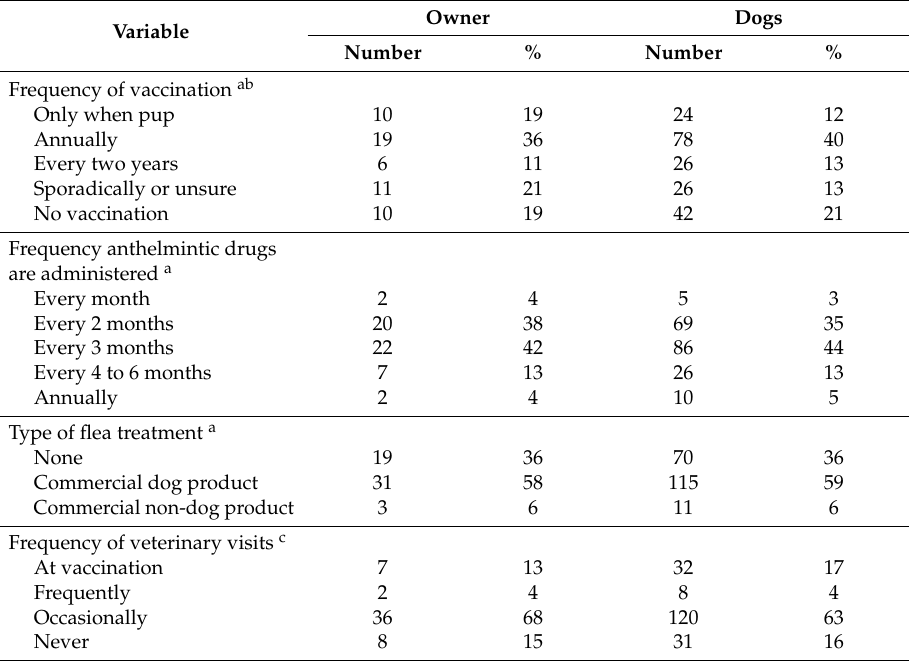
Table 3. Characteristics of preventive health regimes for owners and working dogs from 54 owners and their 196 dogs. Data from a cross-sectional survey of 54 owners that completed a questionnaire about husbandry and management of their